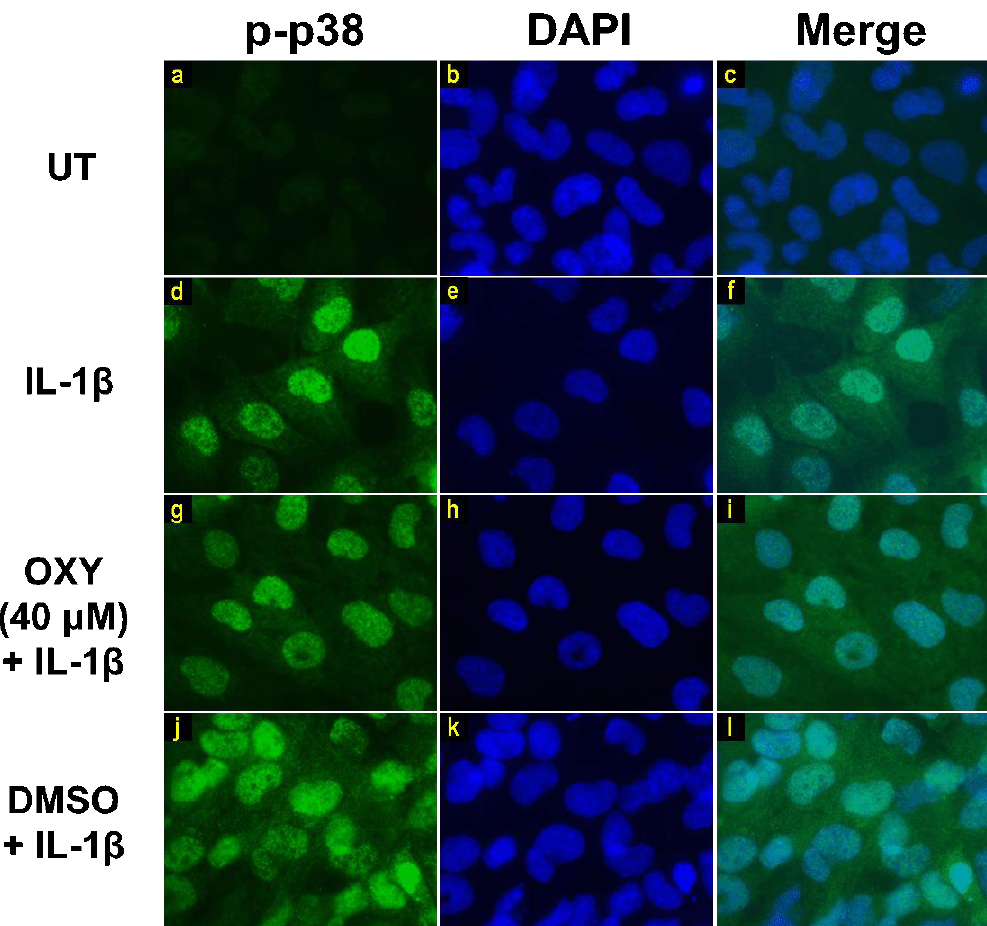
Figure 9. Immunofluorescence study showing the effects of OXY on p38 phosphorylation in response to IL-1β activation in HMC3 cells. Representative images from immunofluorescence study showing p38 phosphorylation (green) of untreated cells ( a–c ), IL-1β-stimulated cells ( d–f ), IL-1β-stimulated cells with the presence of OXY at 40 μM ( g–i ), or DMSO ( j–l ). Nuclei (blue) were stained with DAPI. The micrographs were captured at 100× magnification, and data are representatives of three replicates.